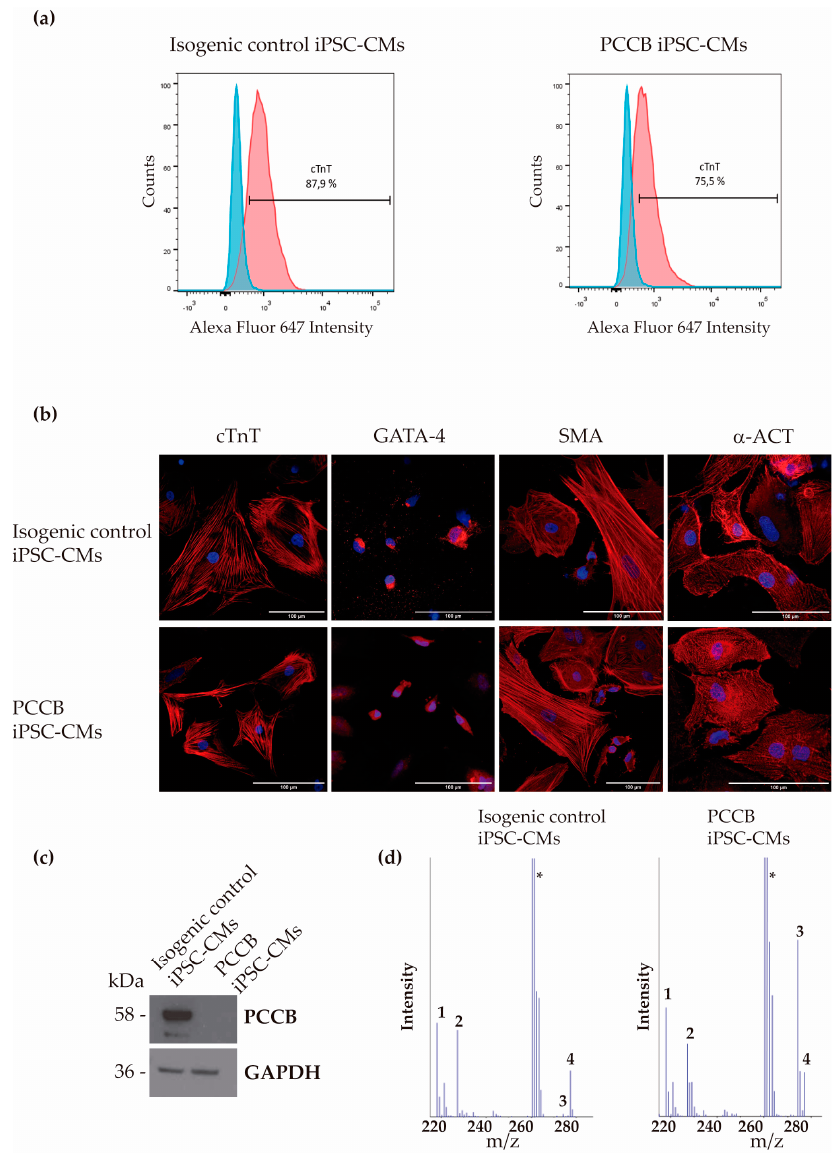
Figure 1. Expression of cardiac and PCCB proteins in isogenic control and PCCB iPSC-CMs. ( a ) Flow cytometry analysis for cTnT cardiac marker. A representative experiment for cTnT expression is shown. ( b ) Immunofluorescence analysis for cTnT, GATA-4, SMA, and α -ACT in iPSC-derived cardiomyocytes; scale bar: 100 µm. ( c ) Representative blot of the analysis of PCCB protein in the cardiomyocytes generated from both iPSC lines. GADPH was used as the loading control. ( d ) Acylcarnitine analysis by tandem mass spectrometry. (1) free carnitine; (2) deuterated free carnitine (internal standard); (3) propionylcarnitine; (4) deuterated propionylcarnitine (internal standard); (*) culture medium, interfering compound.